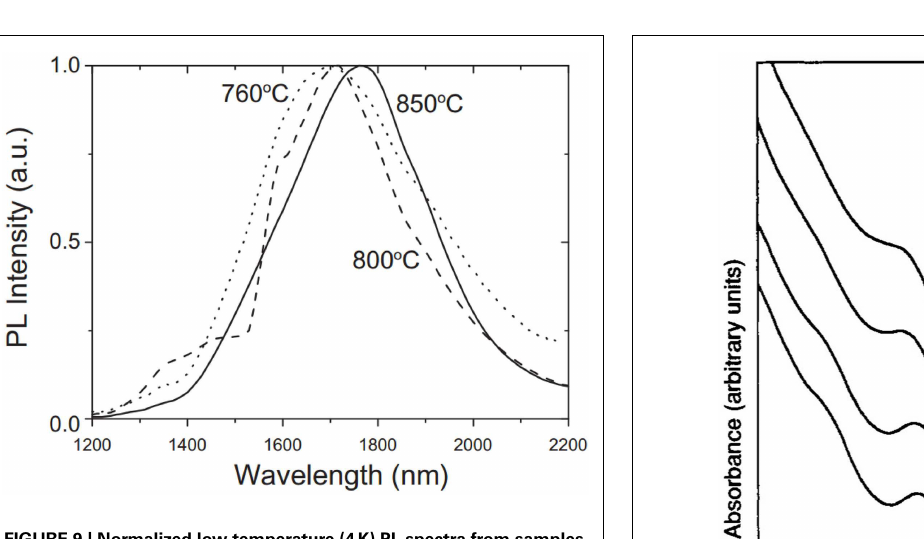
FIGURE 9 | Normalized low temperature (4K) PL spectra from samples electron beam annealed at 760, 800, and 850°C, respectively (Carder et al., 2013) .